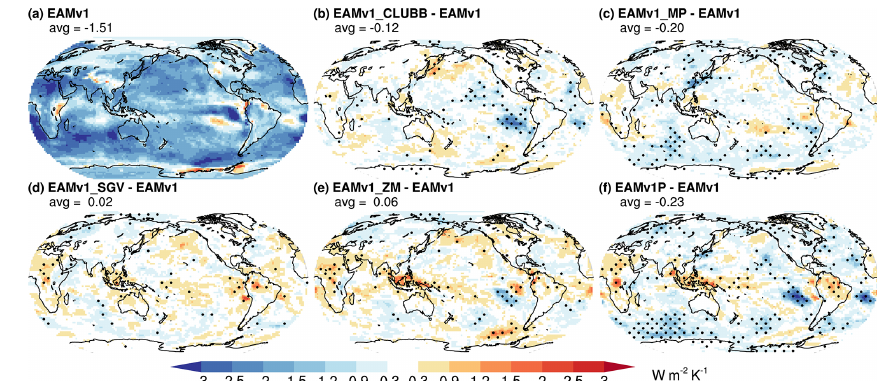
Figure 17. Climate feedback parameter (Cess et al., 1989).